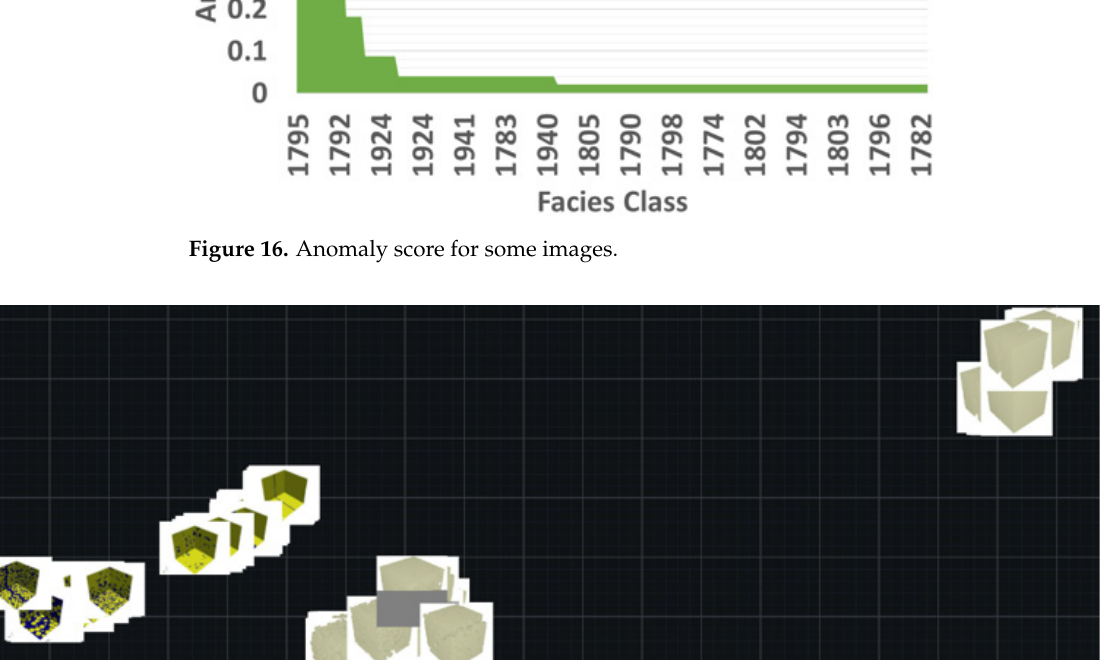
Figure 17. Image prediction and classification with supervised learning.